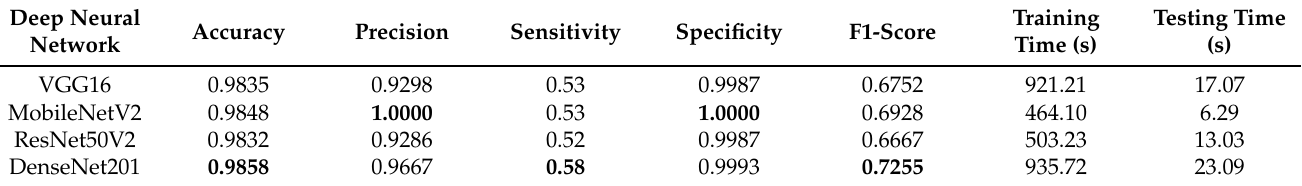
Table 4. The performance of the pre-trained deep neural networks on the COVID-Xray-5k dataset.